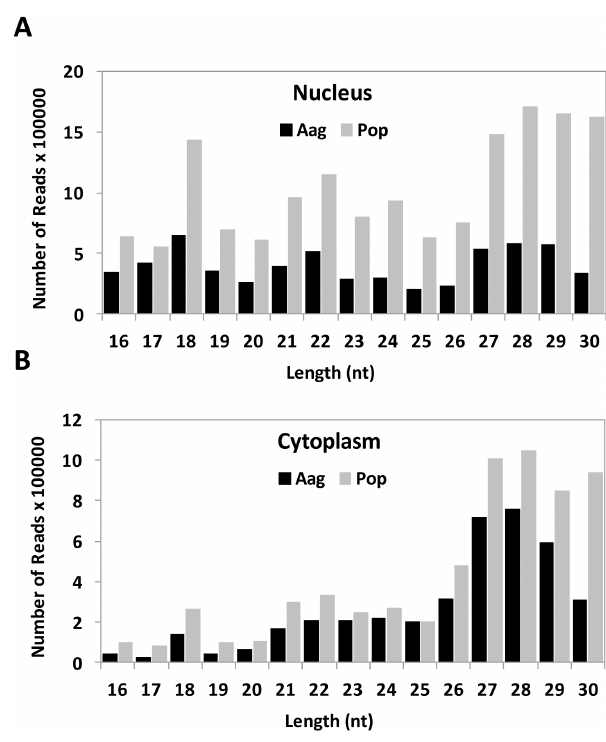
Figure 5. Length distribution of mappable reads obtained from deep sequencing from the four libraries deep sequenced using RNA samples from the nucleus (A) and the cytoplasm (B) of Aag2 and Pop cells.